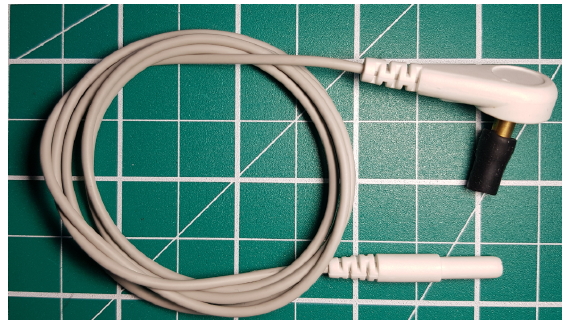
Figure 2. Conductive rubber